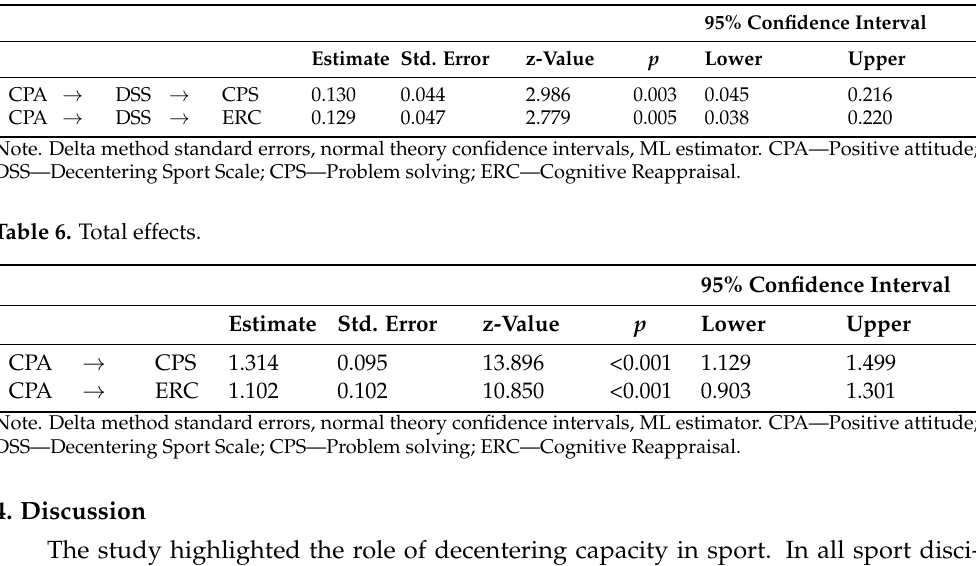
Table 5. Indirect effects.